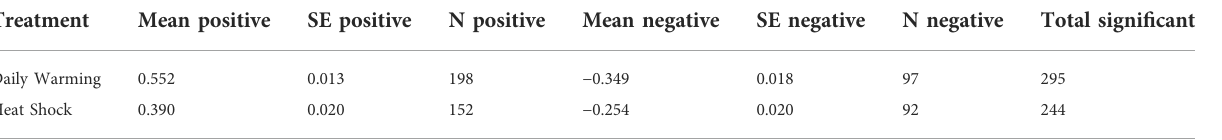
TABLE 5 Signi fi cant gene correlations in each warming